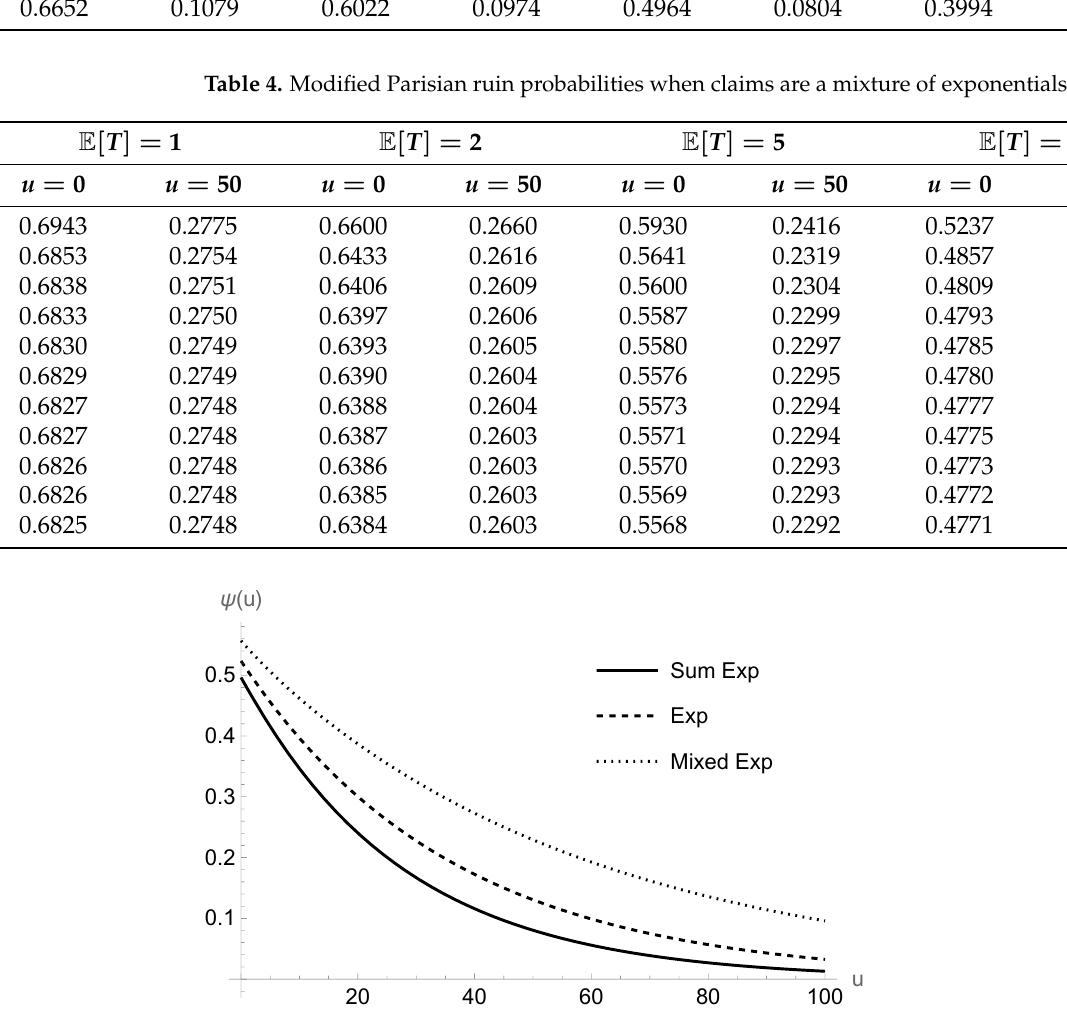
Figure 3. Modified Parisian ruin probability ψ ( u ) for three claim distributions when E [ T ] = 5 and n =